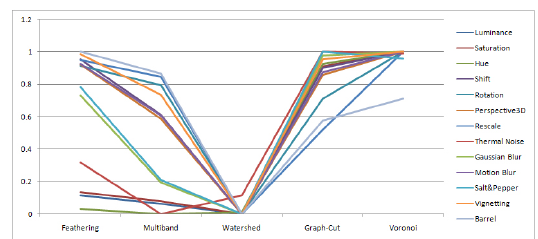
Figure 12. Mosaicing - Distortion PSNR MSE Normalized Response